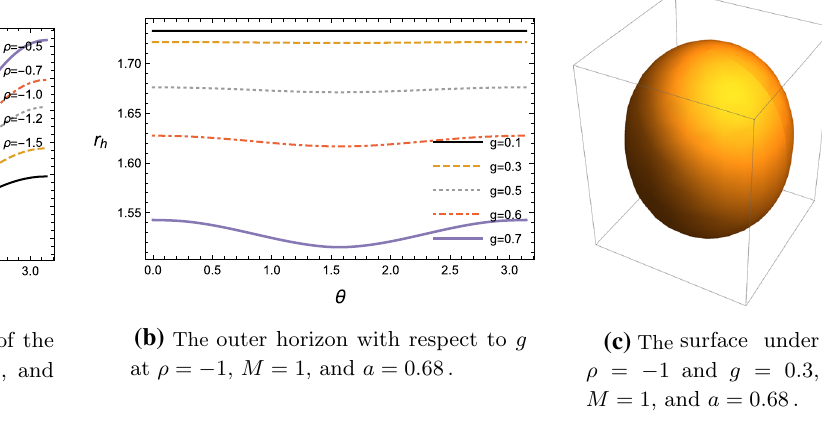
The extremal spin parameter wit respect to θ at g = 0 . 3 and M = 1. Fig. 4 The extremal spin parameter for a negative ρ